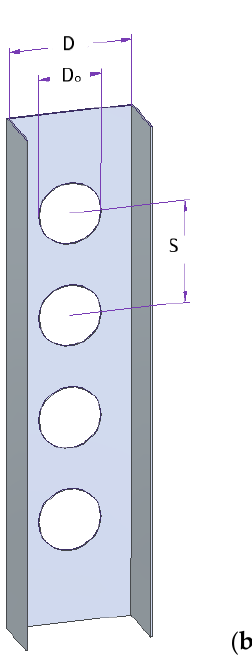
Figure 4. Shapes and dimensions of holes: ( a ) circle, ( b ) square, ( c ) hexagonal.